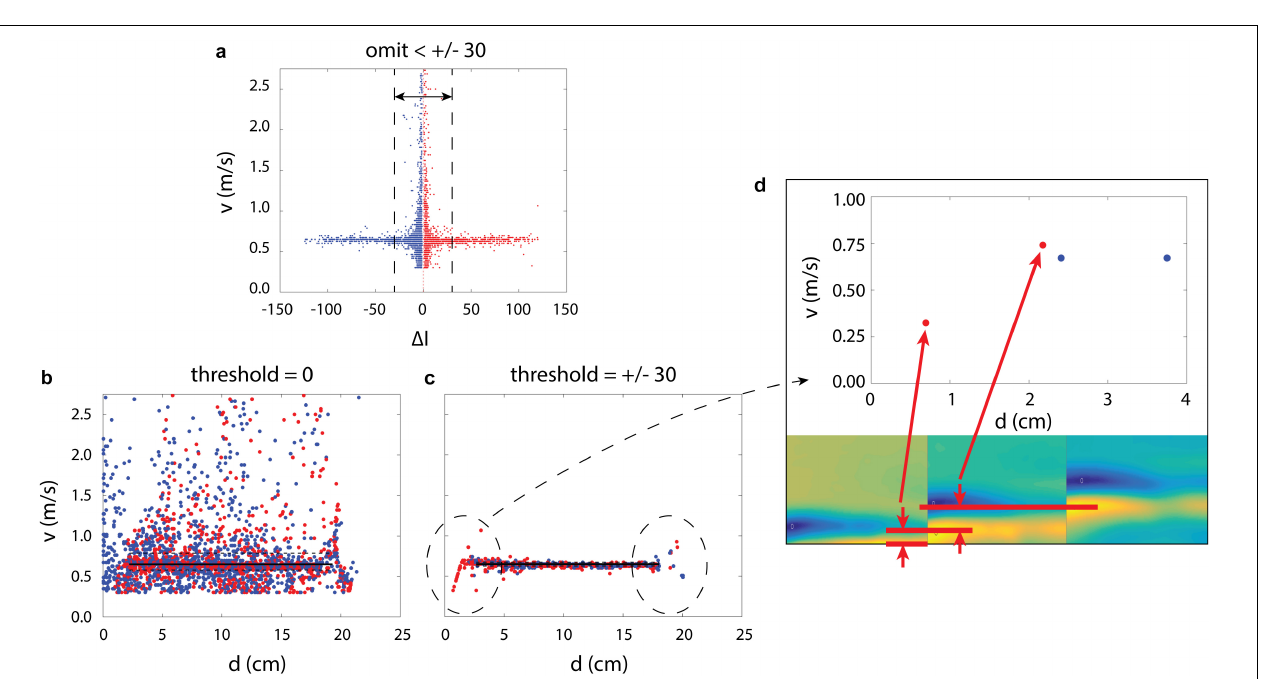
FIGURE 3 | A processing example of experiment Ex7. (a) Frames are cropped to a narrow strip, aligned to the direction of the wave travel. (b) The difference in light intensity, (cid:49) I, allows the wave to be identified. The yellow and blue regions respectively represent the wave’s previous and current location and the waves centers are marked by the “+” symbols. (c) The corresponding velocity is plotted against the travel distance along the processing strip. Red and blue dots correspond to the movement of the yellow and blue regions, respectively.